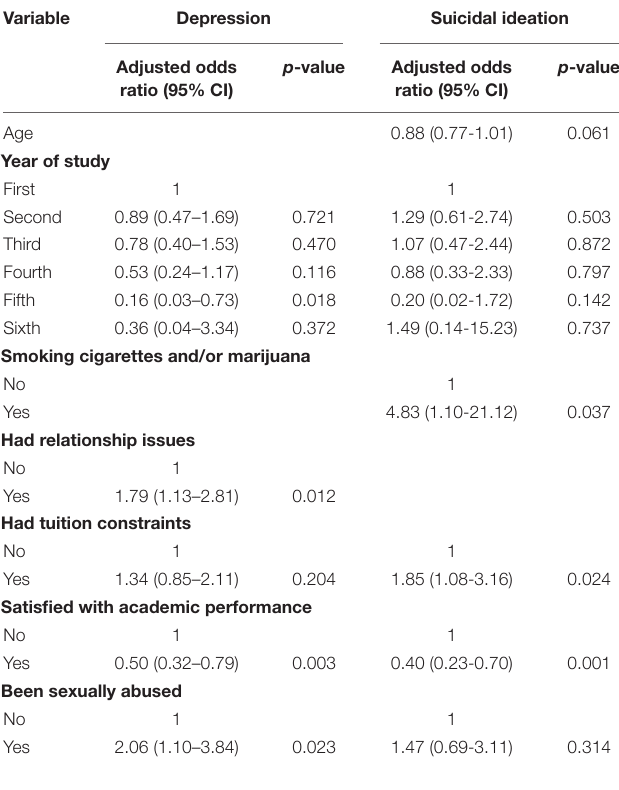
TABLE 3 | Multivariate logistic regression analysis of factors associated with depression and suicidal ideation.